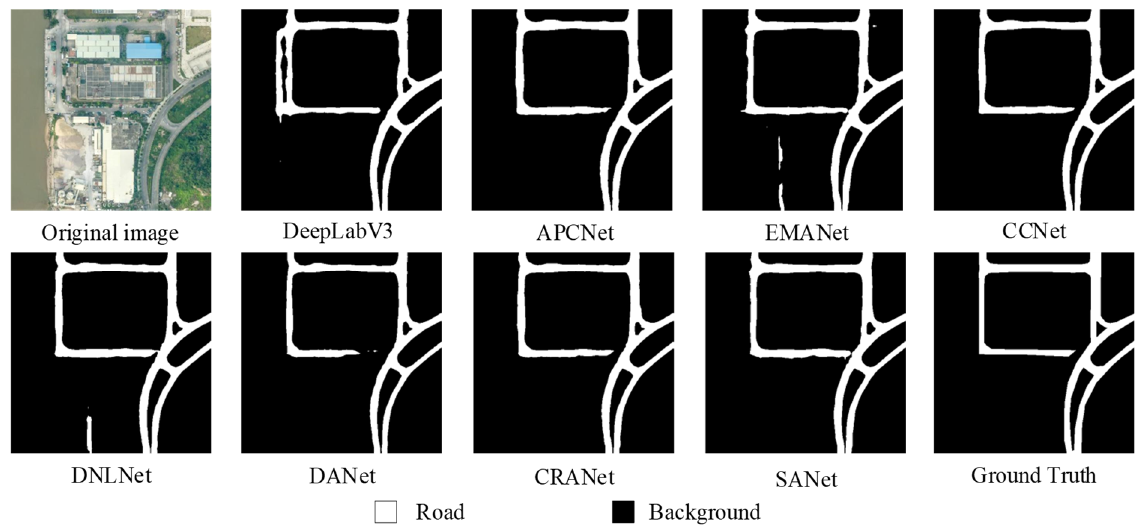
Figure 17. Comparison of visual results of each method based on the CHN6-CUG dataset.